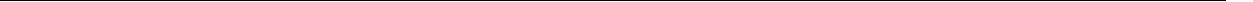
Fig. 2 Mural Pparg overexpression leads to metabolic bene fi ts in obesity. a Glucose tolerance tests of control and Mural- Pparg TG mice after 16 weeks of dox-diet feeding. Two-way ANOVA, * p < 0.05; Control-Chow, n = 7; Mural- Pparg TG -Chow, n = 7; Control-HFD, n = 8; Mural- Pparg TG -HFD, n = 9. Data points represent mean + s.e.m. b Insulin tolerance tests of control and Mural- Pparg TG mice after 16 weeks of dox-HFD feeding. Student ’ s t -test, * p < 0.05; Control-HFD, n = 8; Mural- Pparg TG -HFD, n = 9. Data points represent mean + s.e.m. c Six-hour fasting serum insulin levels in control and Mural- Pparg TG mice after 16 weeks of dox-diet feeding. Two-way ANOVA, * p < 0.05; Control-Chow, n = 7; Mural- Pparg TG -Chow, n = 7; Control-HFD, n = 8; Mural- Pparg TG -HFD, n = 9. Bars represent mean + s.e.m. d The glucose infusion rate needed to maintain euglycemia (~137 mg/dl) during hyperinsulinemic – euglycemic clamp assays of conscious unrestrained control and Mural- Pparg TG mice after 16 weeks of dox-HFD feeding. Student ’ s t -test, * p < 0.05; Control-HFD, n = 7; Mural- Pparg TG -HFD, n = 5. Bars represent mean + s.e.m. e Basal and clamped rates of endogenous glucose production during hyperinsulinemic – euglycemic clamp assays of control and Mural- Pparg TG mice after 16 weeks of dox-HFD feeding. Student ’ s t -test, * p < 0.05; Control-HFD, n = 7; Mural- Pparg TG -HFD, n = 5. Bars represent mean + s.e.m. f Rates of glucose disposal during hyperinsulinemic – euglycemic clamp assays of control and Mural- Pparg TG mice after 16 weeks of dox-HFD feeding. Student ’ s t-test, * p < 0.05; Control-HFD, n = 7; Mural- Pparg TG -HFD, n = 5. Bars represent mean + s.e.m. g – n Western blot analysis of phosphorylated Akt (pAkt), total Akt, and β -actin protein levels in tissue extracts of g , h gonadal WAT, i , j inguinal WAT, k – l liver, and m , n soleus muscle from control and Mural- Pparg TG mice after 16 weeks of dox-HFD feeding. For quanti fi cation, intensity of pAkt band is normalized to that of total Akt band. The mean value of pAkt/Akt intensity ratio of insulin-treated control mice samples were set as 100%. n = 3 individual mice per genotype. Bars represent mean + s.e.m. o Hepatic and p serum triglycerides levels in control and Mural- Pparg TG mice after 16 weeks of dox-diet feeding. Two-way ANOVA, * p < 0.05; Control-Chow, n = 7; Mural- Pparg TG -Chow, n = 7; Control-HFD, n = 8; Mural- Pparg TG - HFD, n = 9. Bars represent mean + s.e.m. q Serum adiponectin levels in control and Mural- Pparg TG mice after 16 weeks of dox-diet feeding. Two-way ANOVA, * p < 0.05; Control-Chow, n = 7; Mural- Pparg TG -Chow, n = 7; Control-HFD, n = 8; Mural- Pparg TG -HFD, n = 9. Bars represent mean +